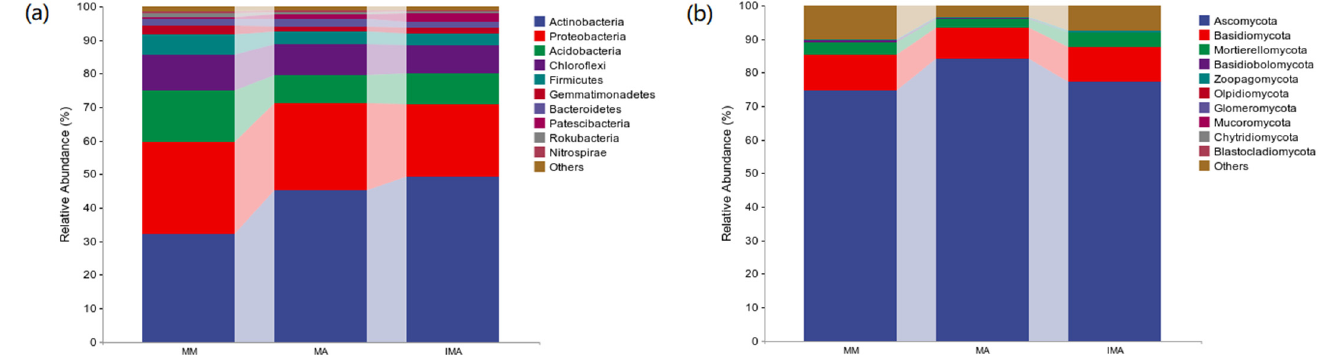
Figure 2. Relative abundance of species composition at the soil microbial phylum level in different treatments. ( a ): Relative abundance of bacterial phylum-level species composition; ( b ): Relative abundance of fungal phylum-level species composition. MM: Morus alba ; MA: Medicago sativa ; IMA: Morus alba – Medicago sativa .